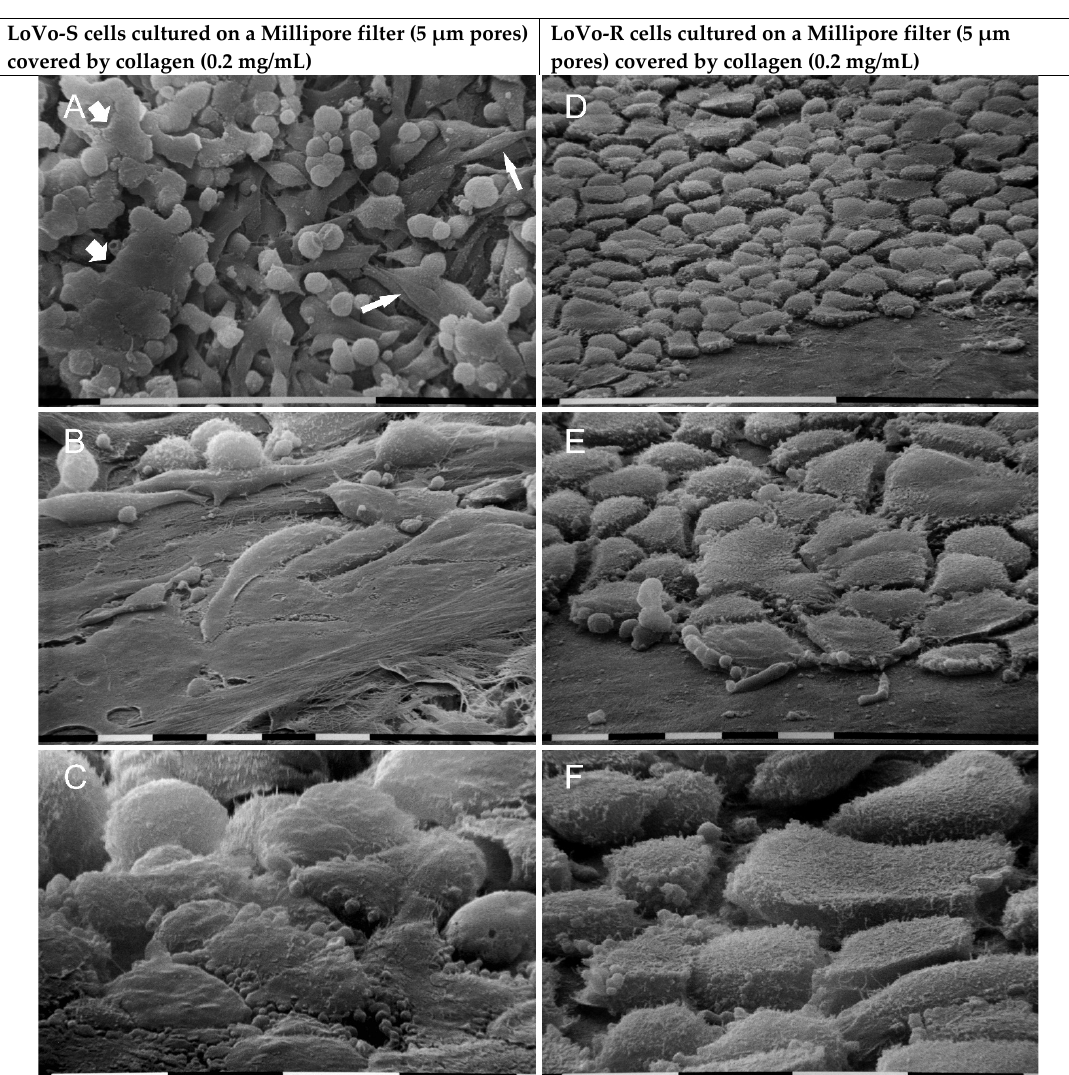
Figure 5. Morphology of LoVo-S and LoVo-R cells cultured for 24 h on Millipore/type I collagen mimicking the normal lamina propria. Grouped LoVo-S cells include polygonal and some elon- gated cells (narrow arrows) but also globular ones growing on the firsts and appearing in tight contact one to each other so as to seem like to be fused together (large arrows) ( A – C ). The cells ex- hibit microvilli but few microvesicles ( B , C ). LoVo-R cells look like polygonal and partially flattened shaped cells with no tight cell-cell contact and prepare themselves to invade the collagen substrate by developing a concave cobblestone shape ( D , E ). All the cells clearly include microvilli ( E , F ). Bar = 100 µm ( A , D ). Bar = 10 µm ( B , C , E , F ). To mimic a desmoplastic lamina propria, cells were cultivated on a Millipore filter covered by type I collagen at the highest concentration (3.5 mg/mL). Under these condi- tions, LoVo-S cells included a layer of polygonal cells in tight cell-cell contact with each other and adhering to the collagen fibrils, which were easily distinguishable. On these cells, many globular ones also grew on the flattened ones (Figure 6A,B). All cells showed